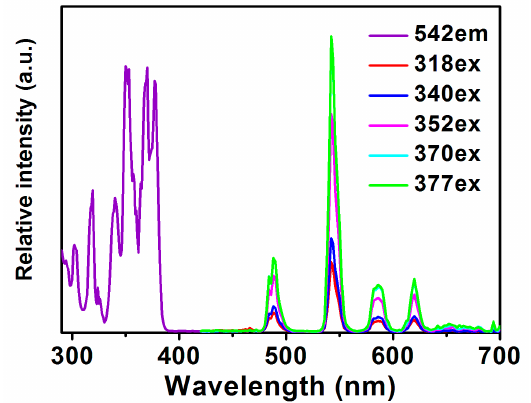
Figure 3. Photoluminescence excitation (PLE) and photoluminescence (PL) spectra of the CTP